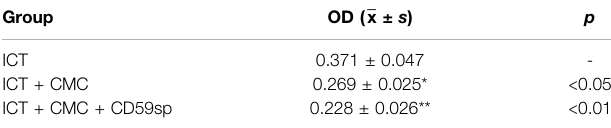
TABLE 1 | Comparison of synergistic antitumor effects of ICT/CMC/CD59sp. Group